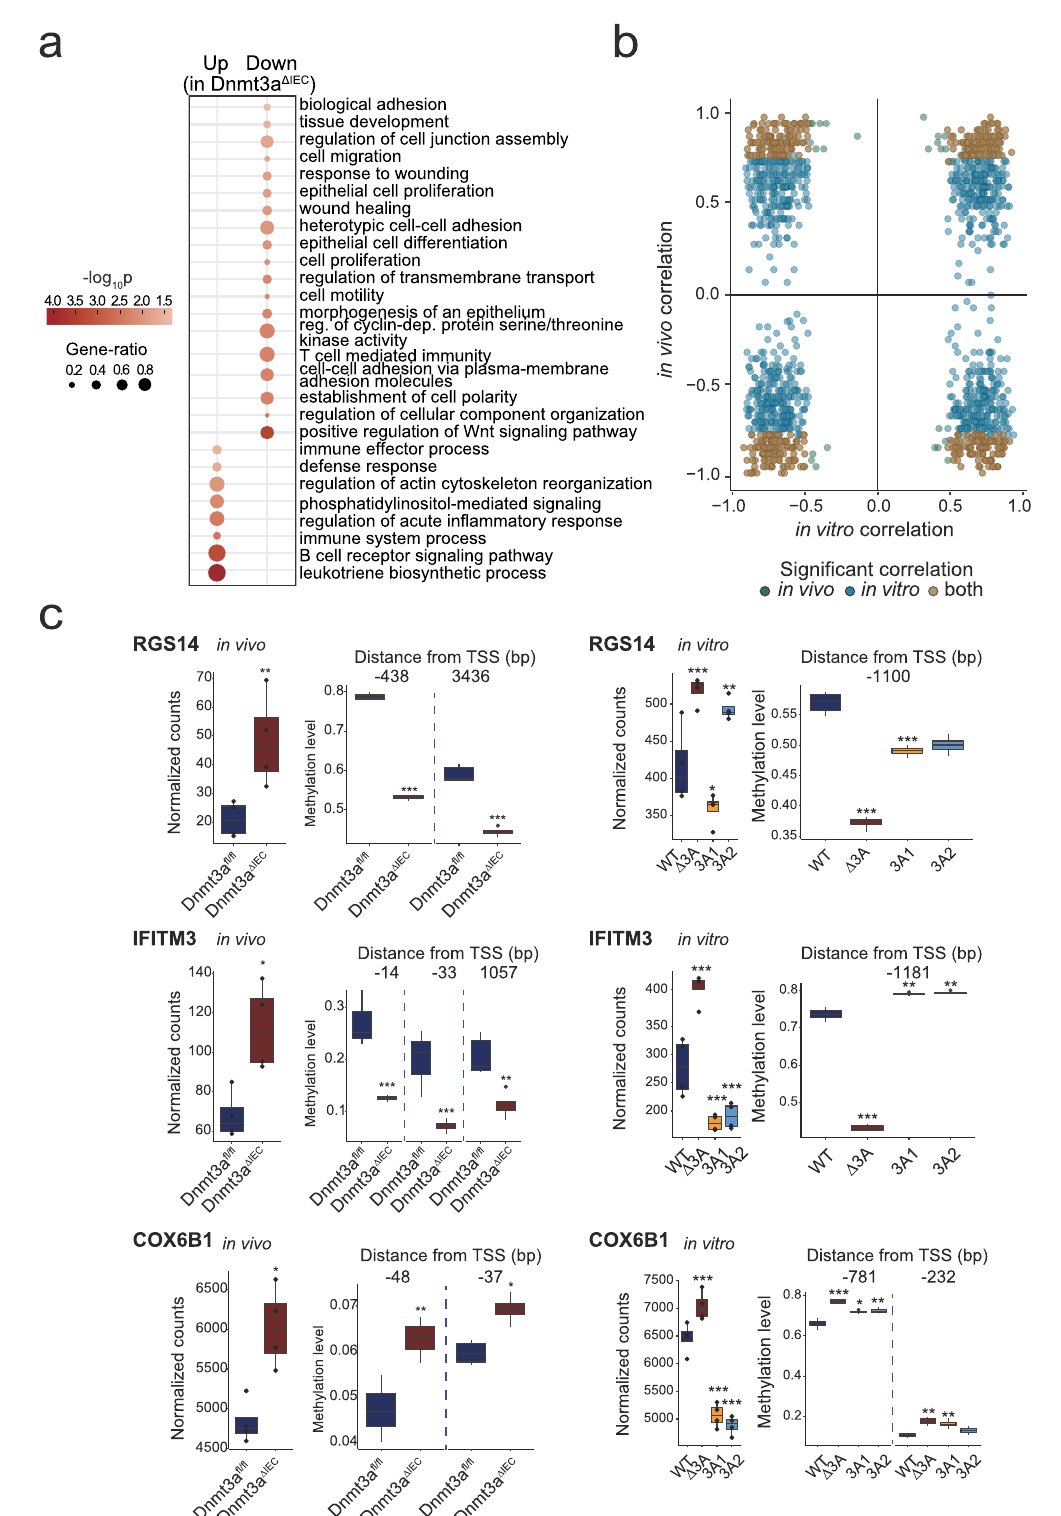
Fig. 5 | Intersection analysis of DNAm-linked DEGs in vivo and in vitro models. a Gene ontology analysis for biological processes enriched in DEGs in Dnmt3a Δ IEC and Dnmt3a fl / fl mice. Dot size is proportional to the gene ratio and color corre- spondstothe p -valueofenrichment(two-sided).TopselectedGOtermsareshown. b Comparisonoftranscription-methylationcorrelationbetweeninvitroandinvivo models. Blue and green dots represent the rescued genes that are correlated with one or more nearby DMPs in vitro and in vivo, respectively. Brown dots represent the rescued genes that are correlated with one or more nearby DMPs in both models. c Common genes regulated by DNMT3A in Caco-2 model (in vitro) and in